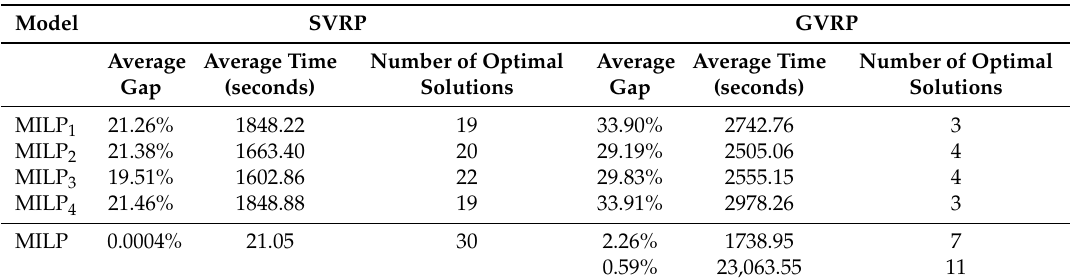
Table 1. Summary of the computational results on Possada et al. [17]